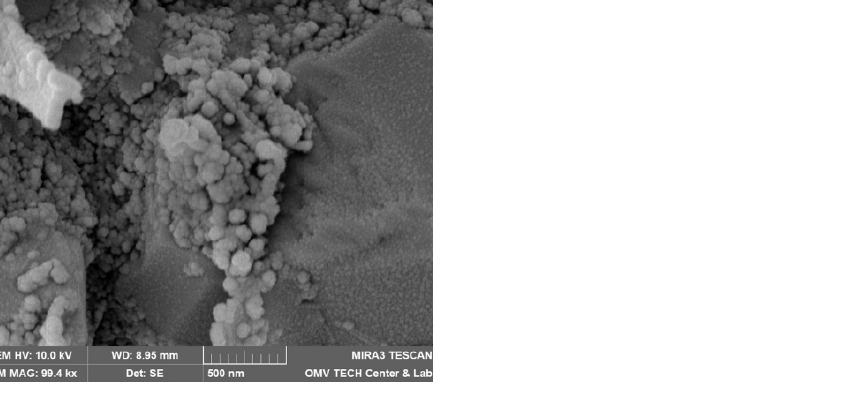
Figure 17. Scanning electron microscope (SEM) images measured for the core material used in this work. A comparison between nanoparticle-covered ( a ) and clean ( b ) kaolinite structures. Note that the smoothed edges in the left image are signs of weathering and not caused by the nanoparticle treatment (( a ): core flood sample of 1 wt% NF A in test water, Keuper; ( b ): untreated sample, Berea).